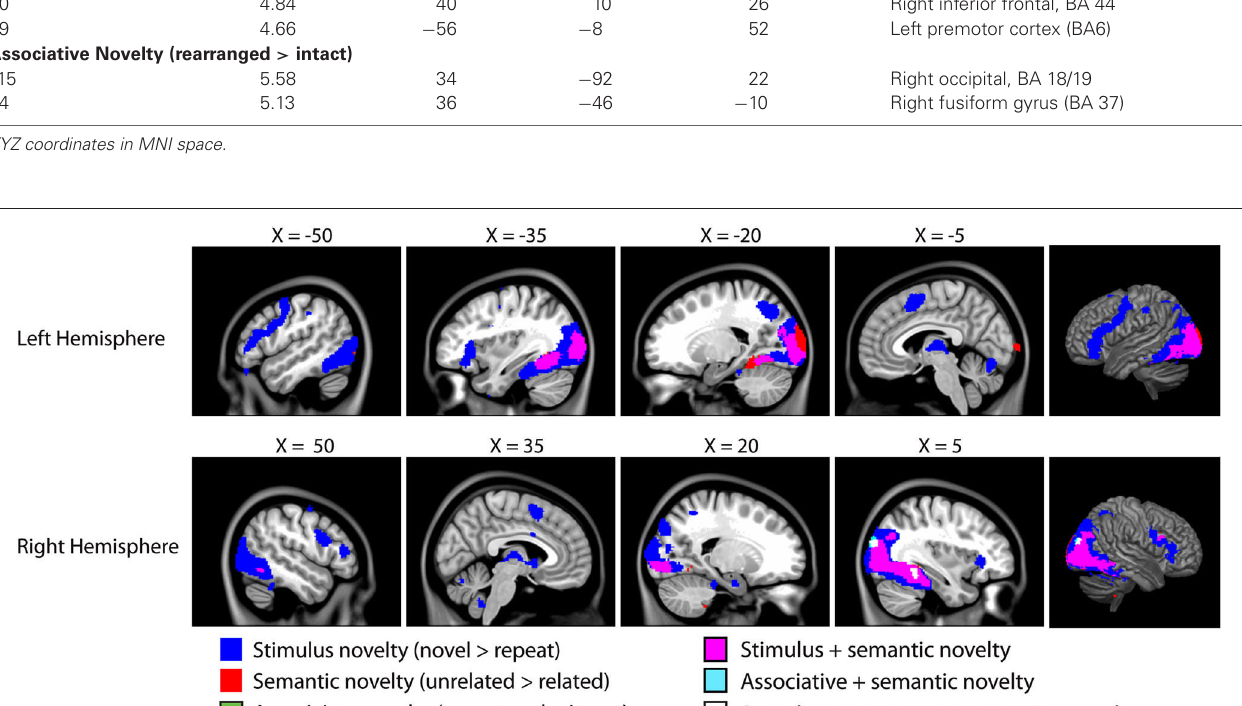
FIGURE 3 | Results of the fMRI analysis on novelty . As we are interested in overlap between these distinct forms of novelty, all contrasts are presented on a single brain, with overlapping activity shown in different colors (see